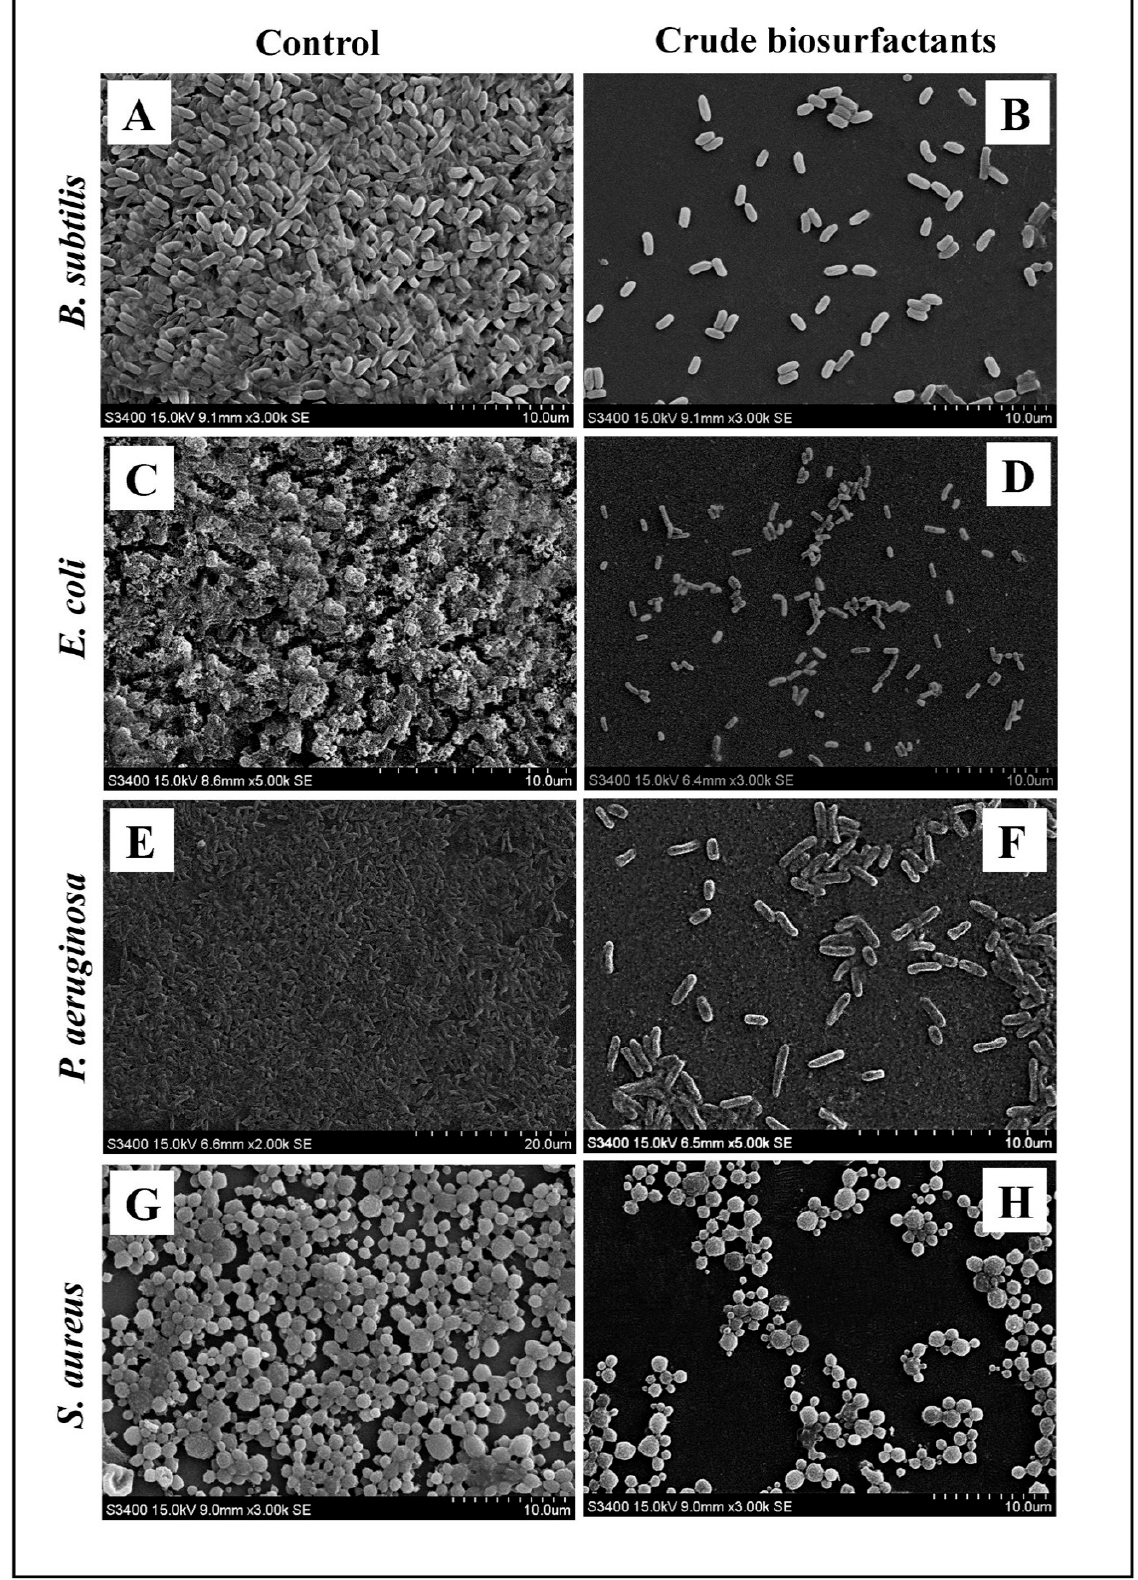
Figure 8. Micrographs of the disrupted matured biofilms of the test pathogens by the P. pentosaceus crude biosurfactant formed on a glass surface at their respective MICs under SEM. Growth control ( A , C , E , G ), with P. pentosaceus crude biosurfactant ( B , D , F , H ).